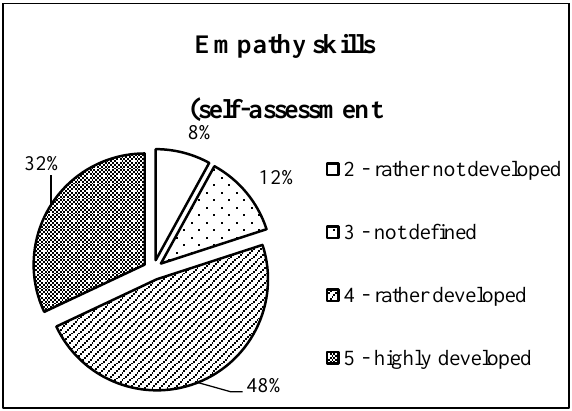
Figure 4. The expert evaluation of expressing empathy competence